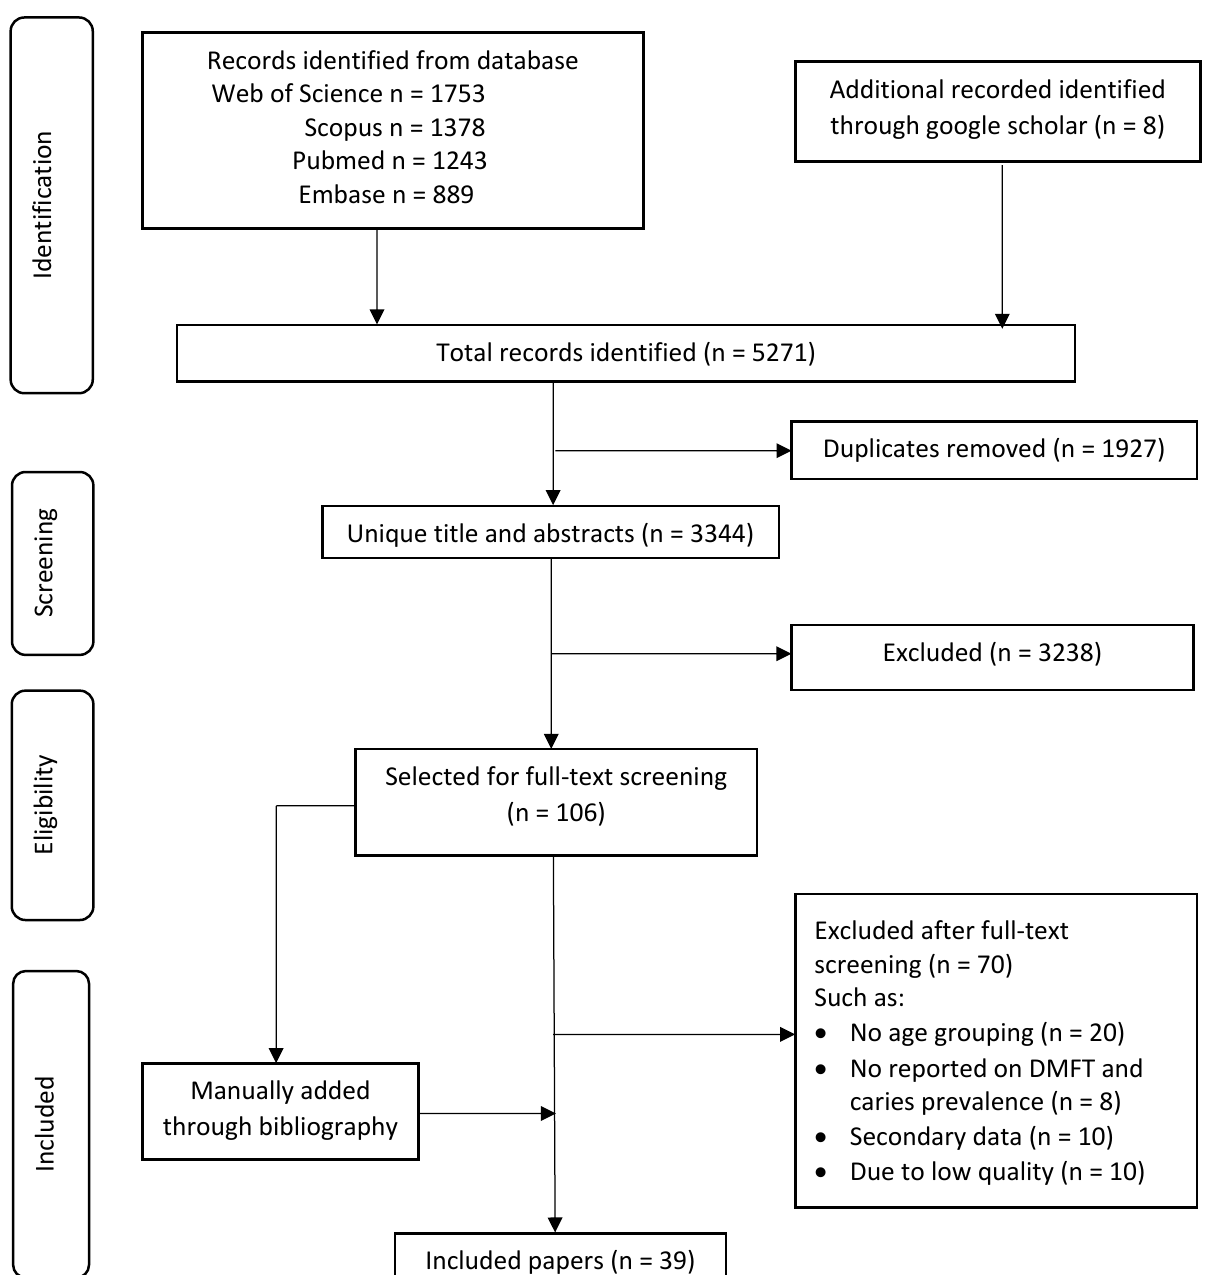
Figure 1. Flowchart for the literature